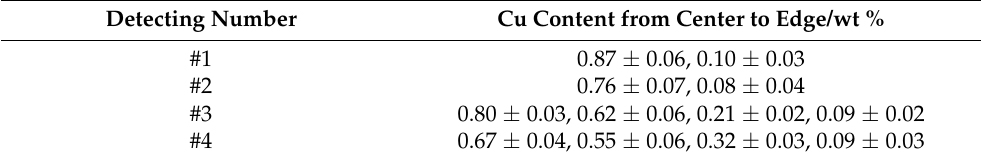
Figure 9. Point EDS analysis of 2.3-Cu sample. Table 2. Cu content of 2.3-Cu cross-section from the center to the